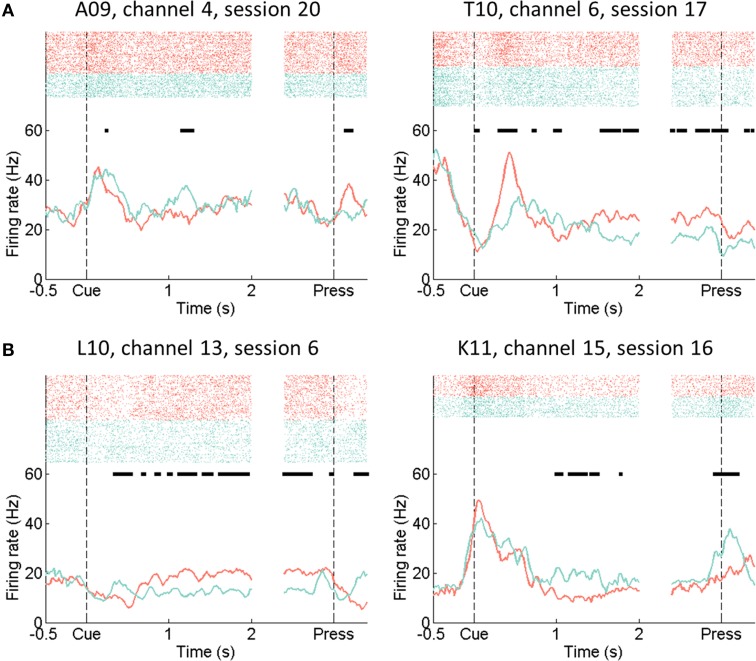
Raster plots and peri-event time histograms of example single units. Firing rate estimated in 100 ms time bins sliding down the time axis with a step size of 20 ms. Red: L-L trials in which the rat moved to the left response lever in response to left side cues. Green: R-R trials with right side movements in response to right side cues. (A) Example AGl units. (B) Example AGm units. Horizontal bars (black) indicate time bins in which directional firing rate modulation was significant (rank-sum test, p < 0.01).